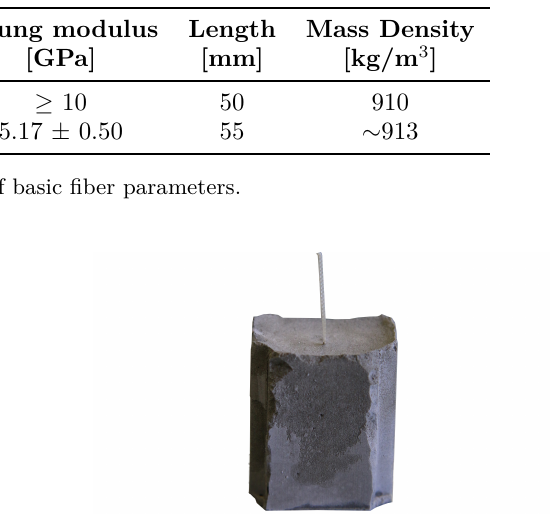
Figure 2. Cement specimen with single fiber for pullout